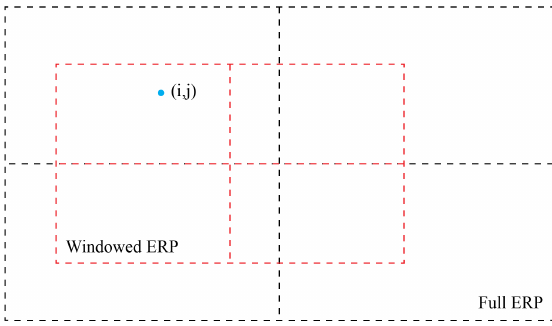
Figure 14. Full equirectangular projection (ERP) and windowed